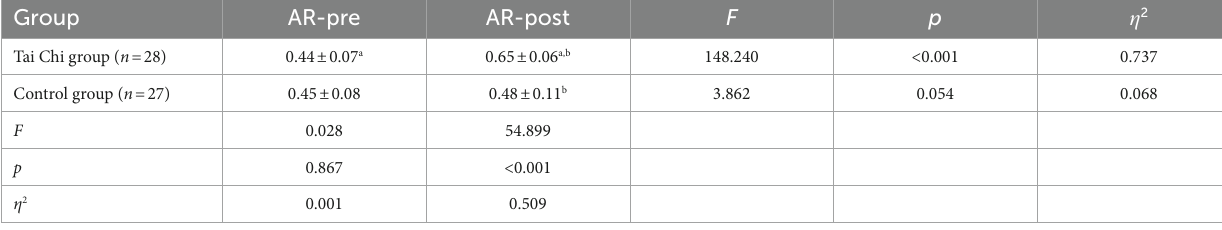
TABLE 2 Results of repeated measures ANOVA c for accuracy rate of working memory capability (M ± SD). Group AR-pre Tai Chi group ( n =